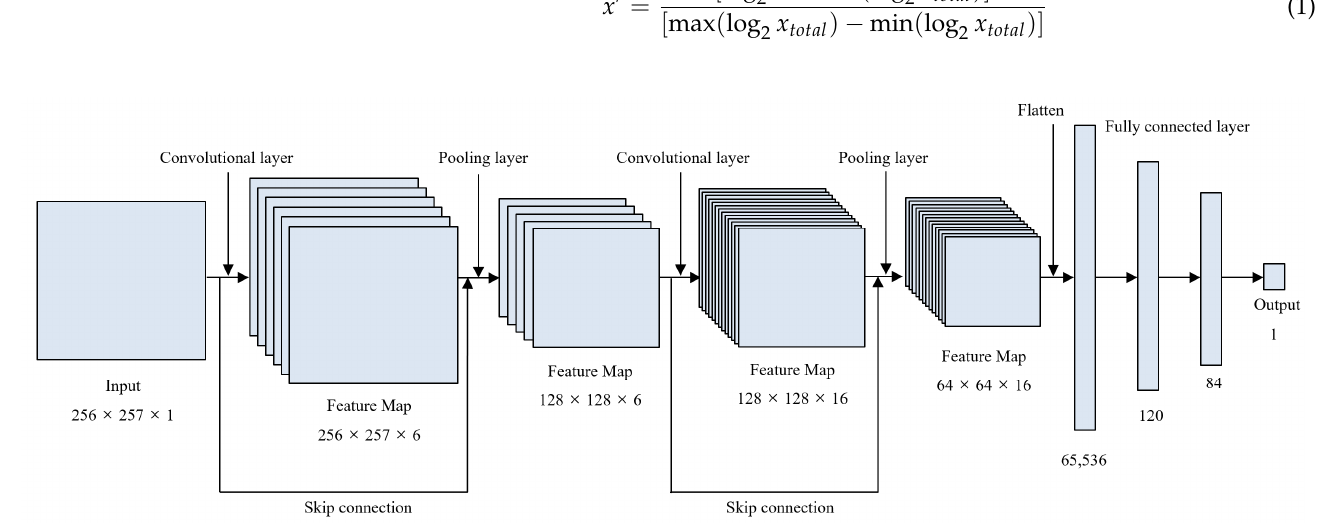
Figure 5. Proposed CNN model architecture using residual block.